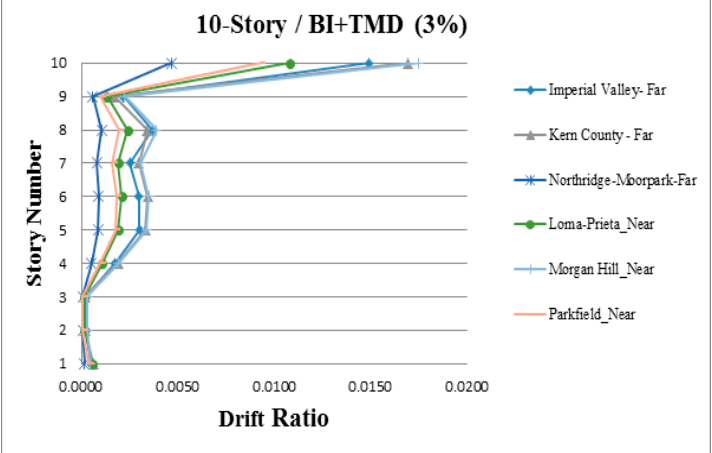
Figure 13. Peak story moments for 10-story base-isolated building with 8 TMDs.